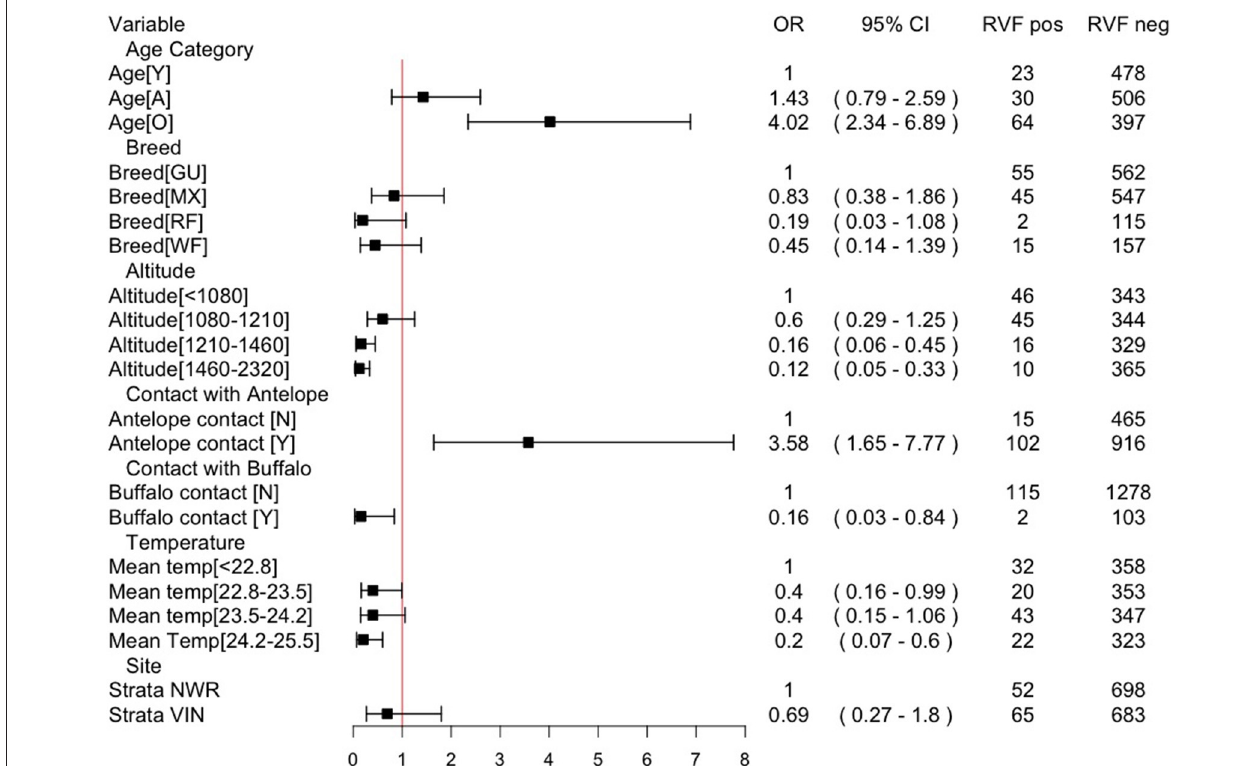
FIGURE 5 | Final multivariable mixed effects logistic regression model, with herd as the random effect, for animal-level seropositivity for RVF in cattle in Cameroon in 2013. Intra-cluster correlation coefficient (ICC) = 0.13; residual error = 3.29; herd-level variance = 0.48; marginal R 2 = 0.323; conditional R 2 = 0.409; Area Under the Curve (AUC) = 0.785. NB Y = young ( < 2 years); A, adult (2–5 years); O, old adult ( > 5years); GU, Gudali; MX, mixed breed; RF, Red Fulani; WF, White Fulani; OR, odds